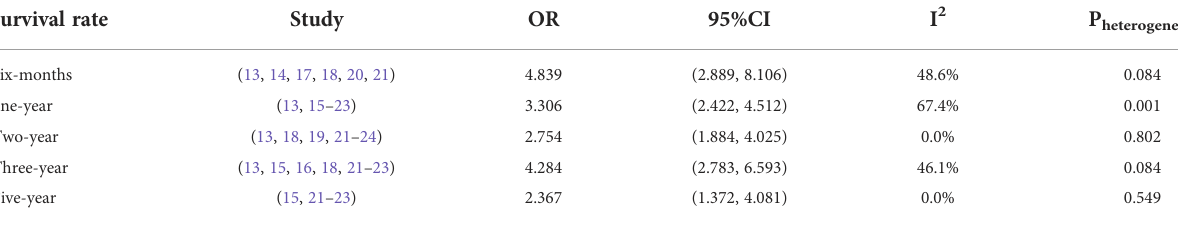
TABLE 2 Survival rate analysis